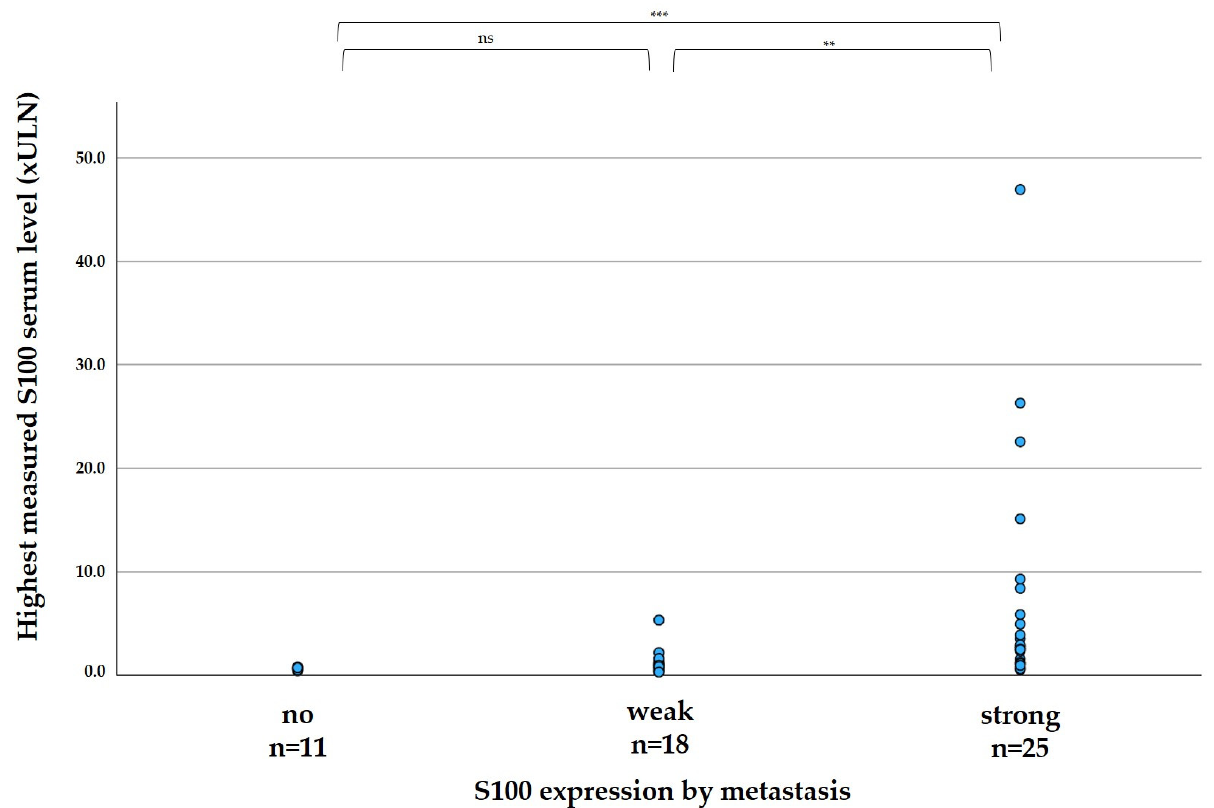
Figure 2. Highest measured S100 serum levels compared between the subgroups of patients with metastases showing no expression, weak expression or strong expression of S100. 56 patients had S100 stains available, two patients were excluded with no S100 serum levels obtained. ns: not significant, p = 0.402 ** p = 0.001, *** p < 0.001.